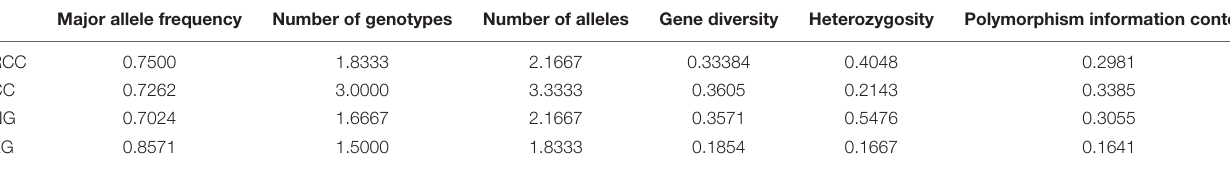
TABLE 2 | Genetic polymorphism indexes for the four fish lines included in this study: RCC, CC, EG, NG. Major allele